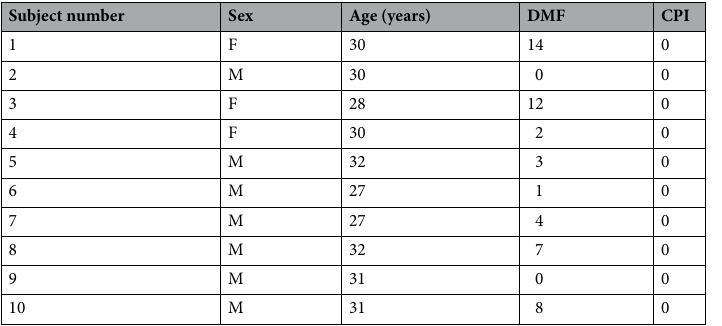
Table 1. Subject characteristics. The subject characteristics are shown. F, female; M, male. A quantification of the experience of dental caries as the total number of teeth that are decayed, missing, or filled (DMF) was used as an index of dental caries. The Community Periodontal Index (CPI) was used as an index of periodontal disease. No clinical signs of caries, gingivitis, or periodontitis were detected, and no systemic disease was observed, in any of the